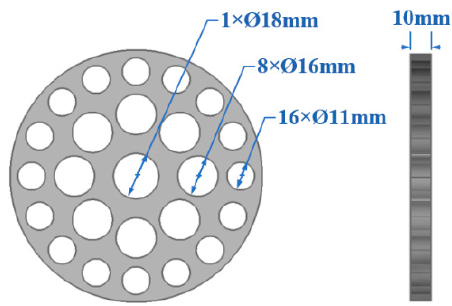
Figure 11. Diagram of plate flow conditioner.